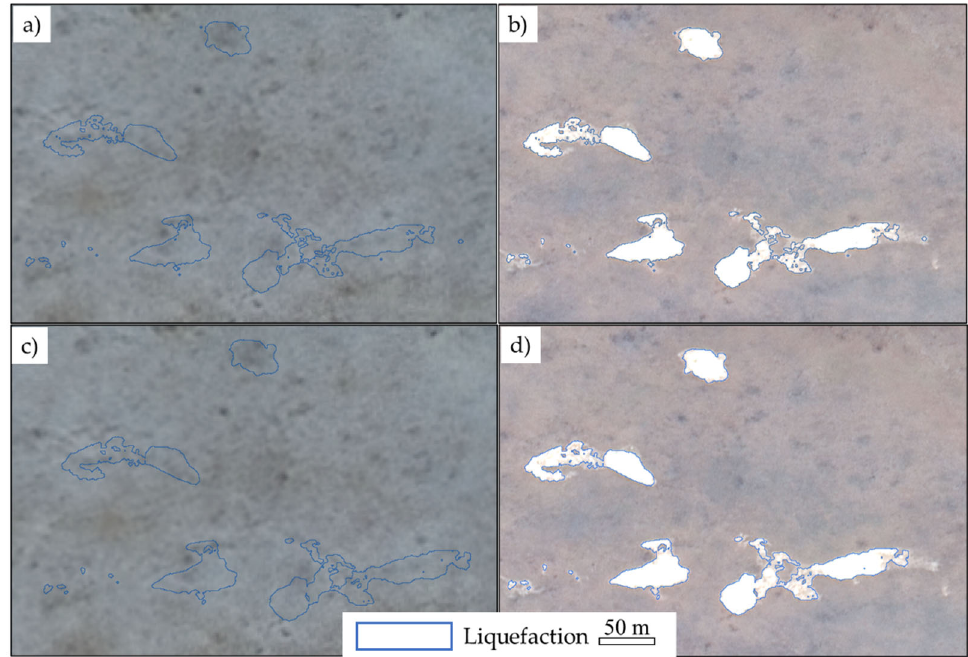
Figure 8. The extracted liquefaction (region Ⅱ ) by the two proposed methods. ( a ) GF-1D images pre-earthquake with liquefaction predicted by RF. ( b ) GF-7 images post-earthquake with liquefaction predicted by RF. ( c ) GF-1D images pre-earthquake with liquefaction predicted by GBDT. ( d ) GF-7 images post-earthquake with the liquefaction predicted by GBDT.